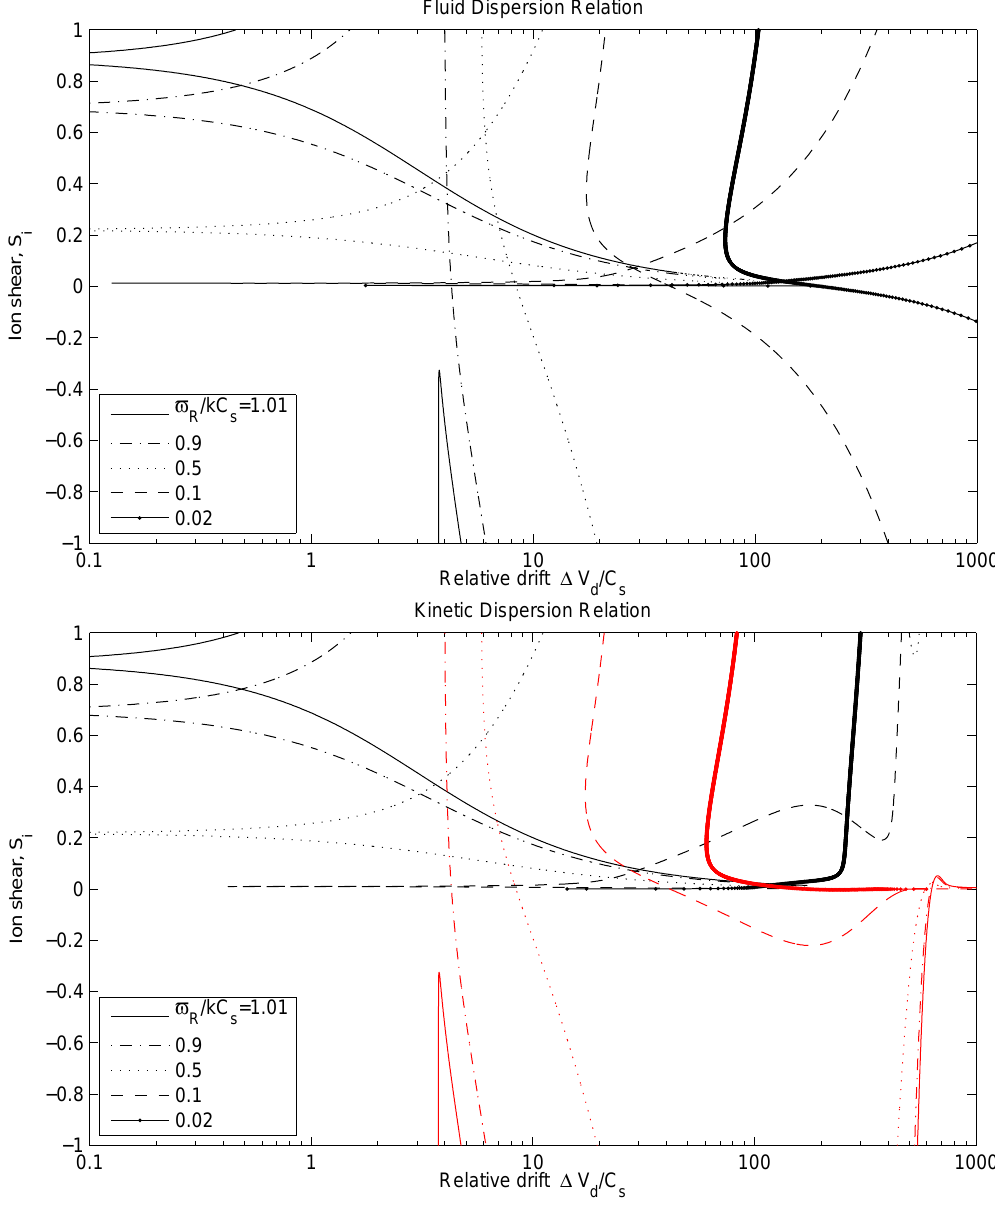
Fig. 1. Threshold conditions obtained from the fluid-like dispersion relation using Eqs. (A1–A5) of St.-Maurice et al. (2006) (top panel) and using the full kinetic dispersion relation Eq. (1) (lower panel). Results are presented for ω R /kC s =0.02 (dot-line), 0.1 (dashed line), 0.5 (dotted line), 0.9 (dash-dotted line) and 1.01 (solid line) for the collisional case using (cid:127) i /(kC s ) = 2, T i /T e = 10 − 6 , ν i /(cid:127) i = 0 . 01 and ν e /ν i = 10 . 0. Red curves in the bottom panel are solutions for which the relative drift never changes signs (crosses zero) as the wave-vector angles are swept from 0 to 90